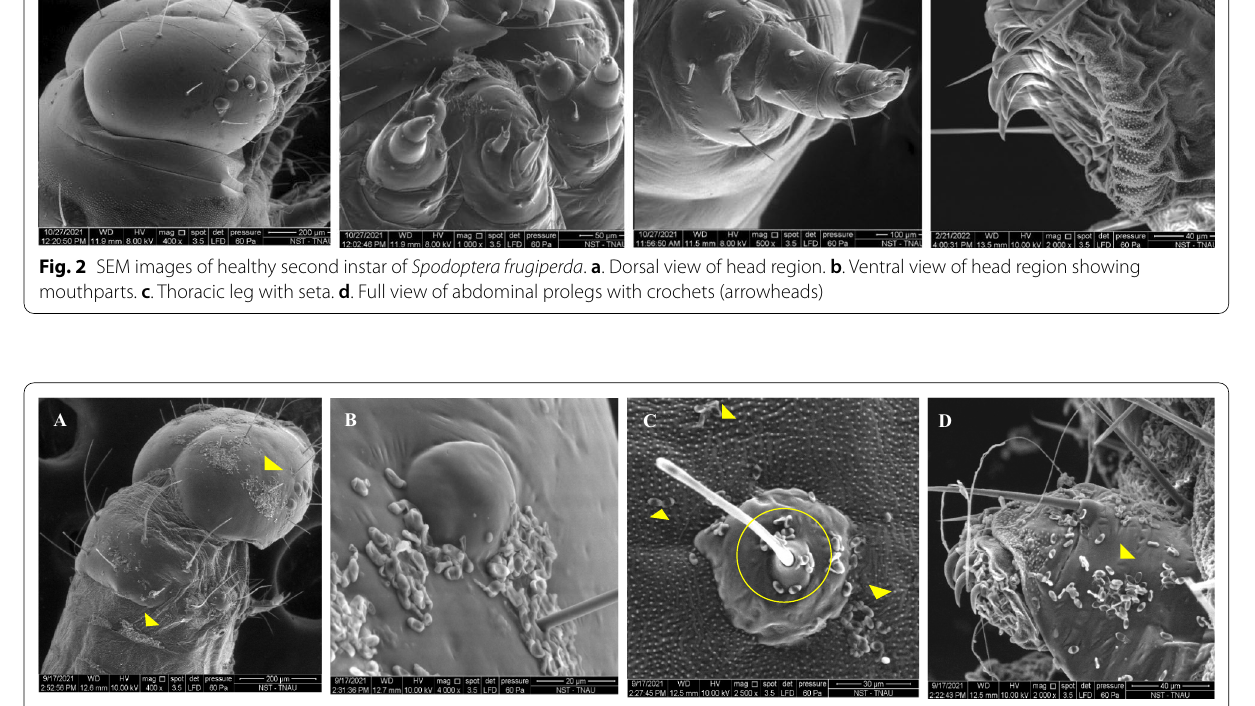
Fig. 3 SEM images of second instar of Spodoptera frugiperda infected with Metarhizium anisopliae (24 hpi). a . Adherence of conidia on head and thoracic region (arrowheads). b . Close-up view of conidial clusters on peripheral region of dorsal ocelli. c . Spores around setal alveoli (circle), conidia adhered to cuticular ornamentations (arrowhead). d . Conidia attached to base of prolegs (arrow